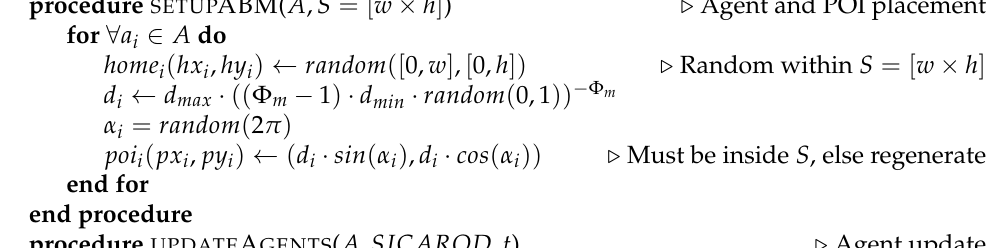
Algorithm 1 Infectious status and position updates for any agent a i during each iteration